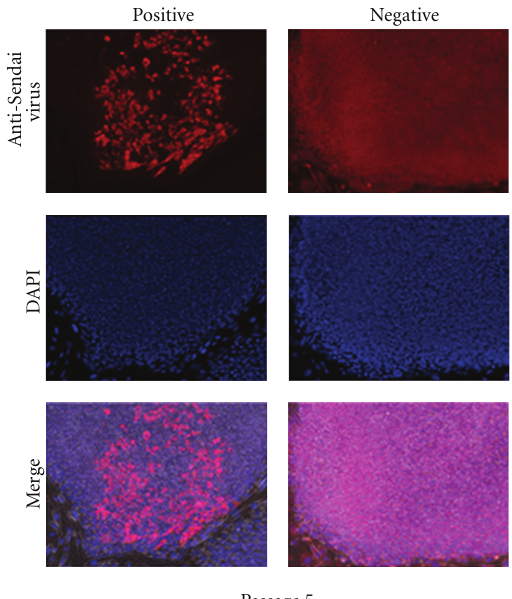
Figure 7: Immunofluorescence staining with anti-Sendai virus vector antibodies to detect virus-free iPSCs. iPSC clones were stained at passage